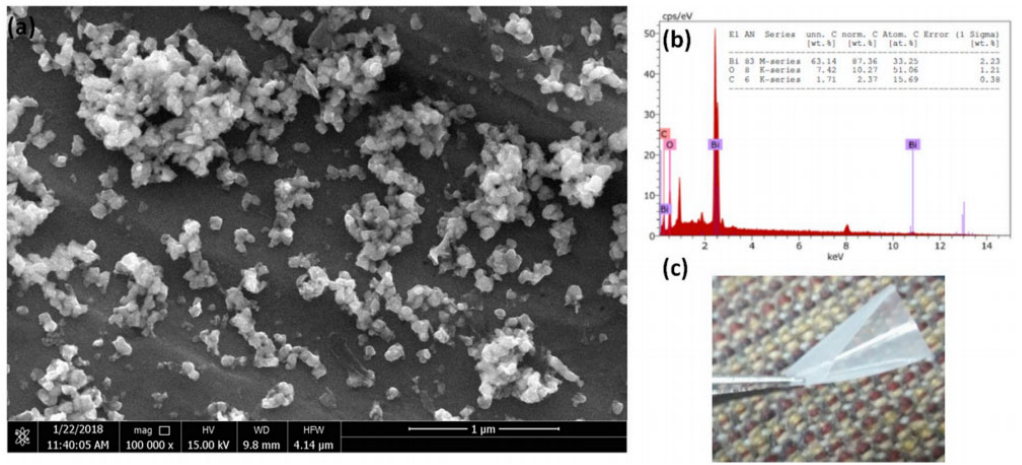
Figure 30. (a) SEM image of Bi 2 O 3 particles deposited on poly(vinyl alcohol) membrane, (b) Figure 30. ( a ) SEM image of Bi 2 O 3 particles deposited on poly(vinyl alcohol) membrane, ( b ) EDS EDS analysis of Bi 2 O 3 , (c) membrane image [132] . analysis of Bi 2 O 3 , ( c ) membrane image Table 10. Characterization of polymeric membranes by EDS.